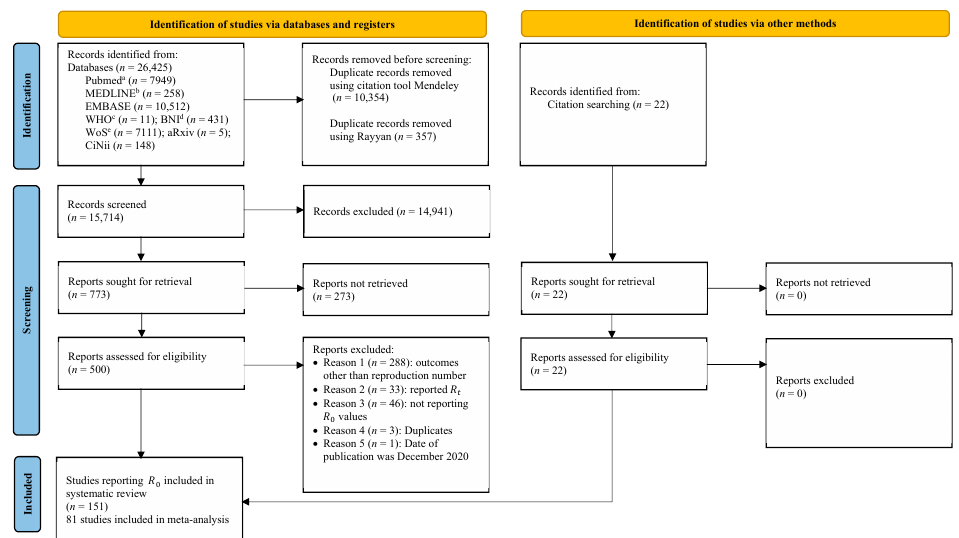
Figure 1. Selection of articles reporting the basic reproduction number of COVID-19 published between 1 December 2019 and 31 September 2020 using a PRISMA flow diagram 2020. Note: a PubMed, LitCovid, MEDLINE (via PubMed); b MEDLINE Complete, CINAHL Plus with full text, APA PsychInfo (vis EBSCO host); c COVID-19 database by the World Health Organization, LILACS (Americas), WPRIM (Western Pacific); d British Nursing Index, Coronavirus Research Database (via Proquest); e Web of